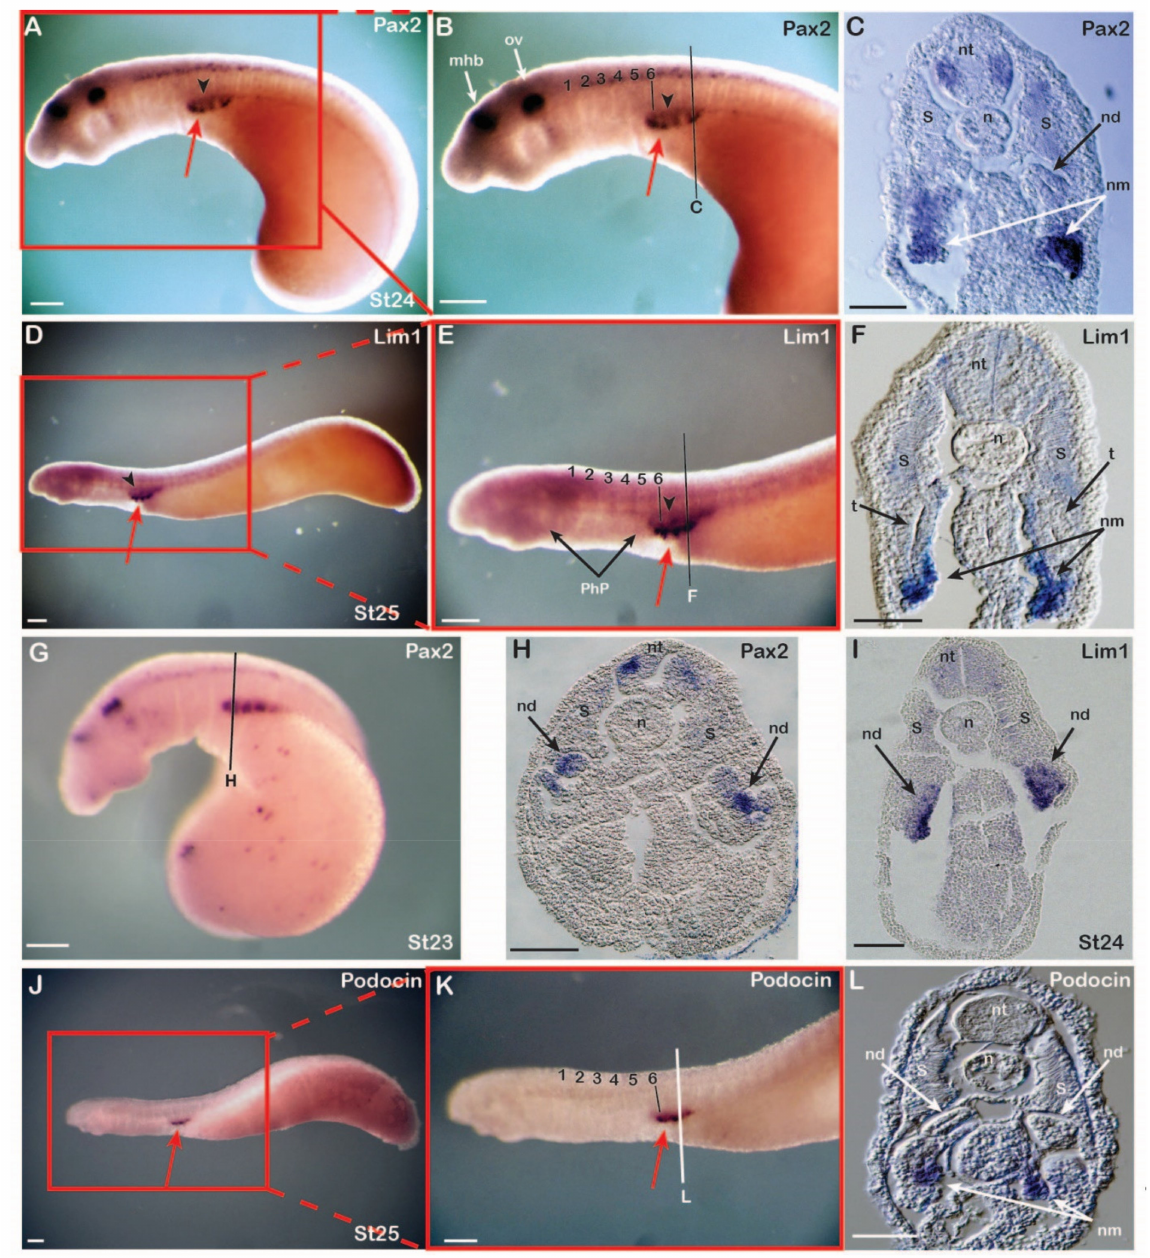
Figure 2. Expression of lamprey nephric genes. Expression of Pax2 ( n = 32) at stage 24 ( A – C ) and stage 23 ( G , H ), of Lim1 ( n = 35) at stage 25 ( D – F ) and stage 24 ( I ), and of Podocin ( n = 10) at stage 25 ( J – L ). Numbers mark the somites from anterior to posterior. Red arrows highlight pronephric glomeruli and arrowheads the pronephric duct. Note the position of somites 1-6 relative to the pharyngeal pouches. Cross sections of embryos showing Pax2 ( C , H ), Lim1 ( F , I ), and Podocin ( L ) expression. The nephric mesenchyme and epithelial structures of the nephric duct are labelled. mhb, midbrain-hindbrain boundary; n, notochord; nd, nephric duct; nm, nephric mesenchyme; nt, neural tube; ov, otic vesicle; PhP, pharyngeal pouches; t, tubule; S, somite; st, stage. Scale bars in ( A , B , D , E , G , J , K ) are 200 µ m and scale bars in ( C , F , H , I , L ) are 50 µ